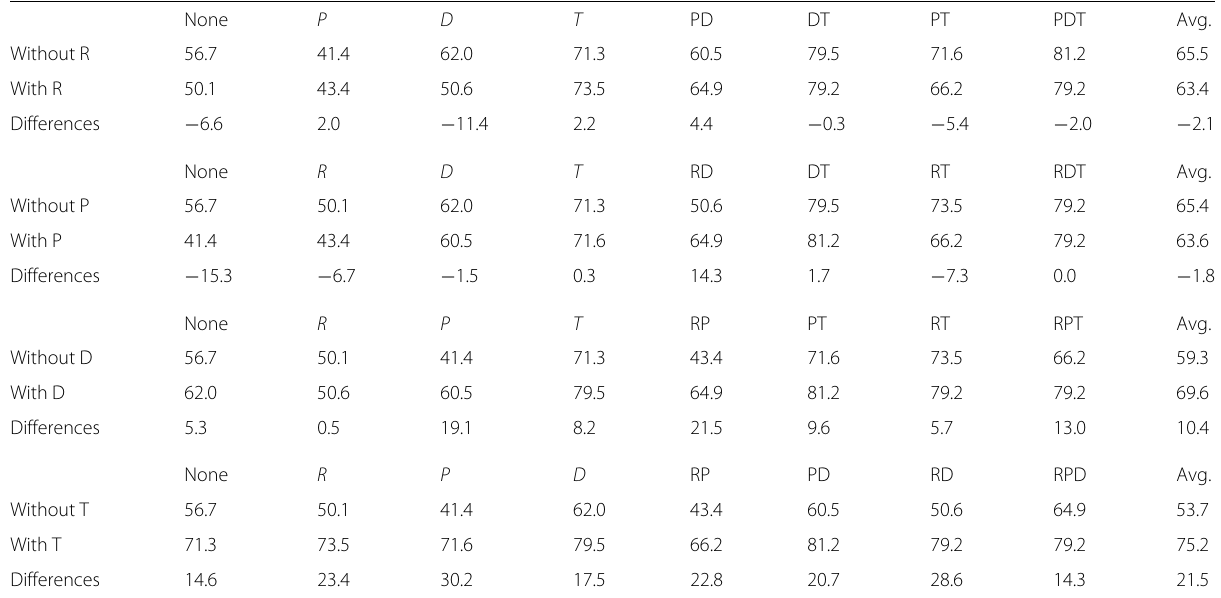
Table 8 Results of the comparison in the generation